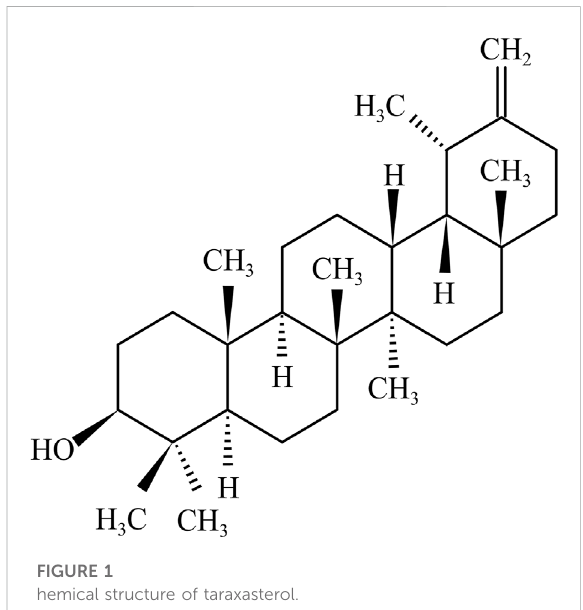
FIGURE 1 hemical structure of